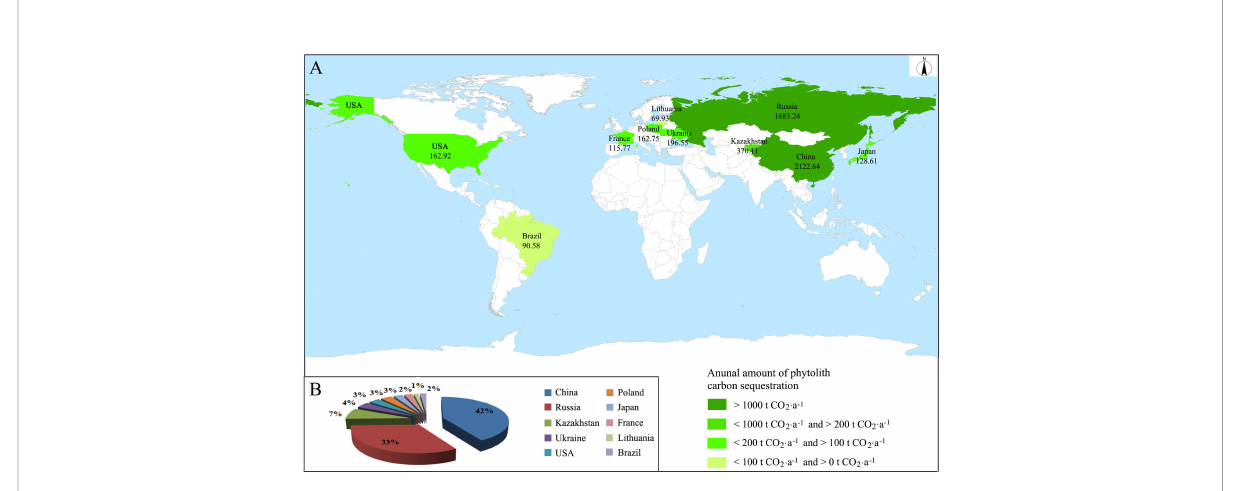
FIGURE 5 Annual amount and distribution of phytolith carbon sequestration of global buckwheat planting in 2018. (A) Distribution, (B) Proportions.